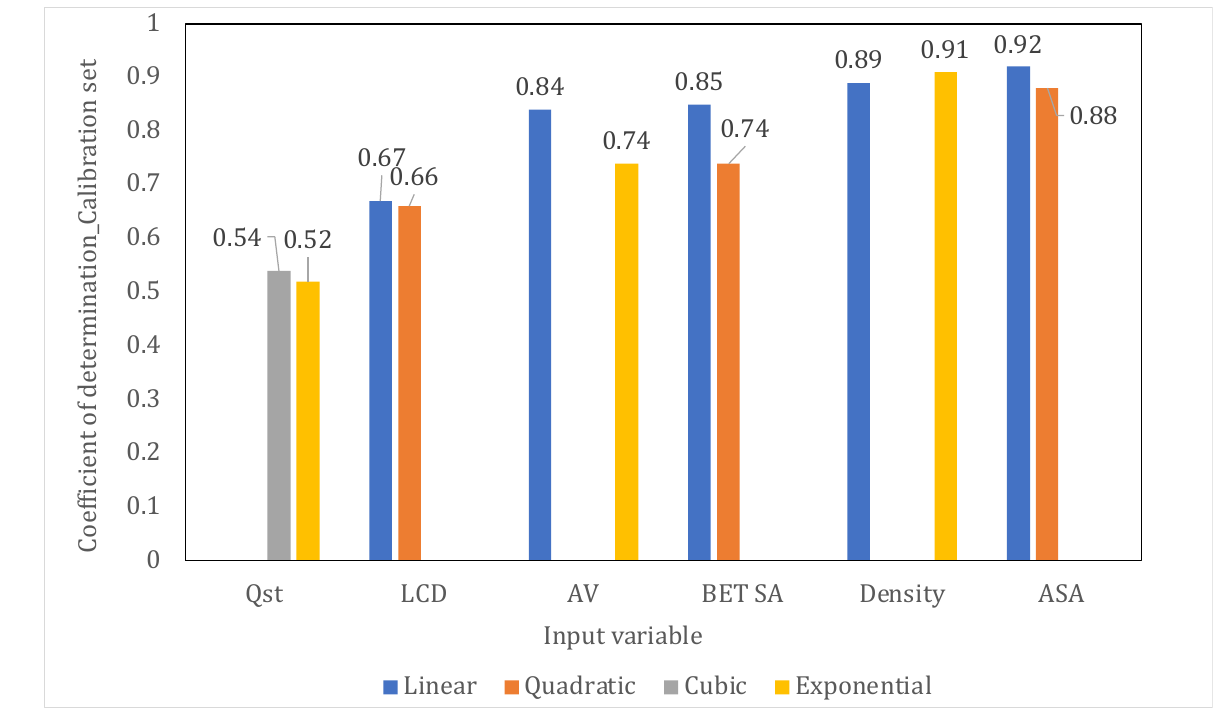
Figure 3. Bar chart representing the data for r 2 each input regressor, with GD as the